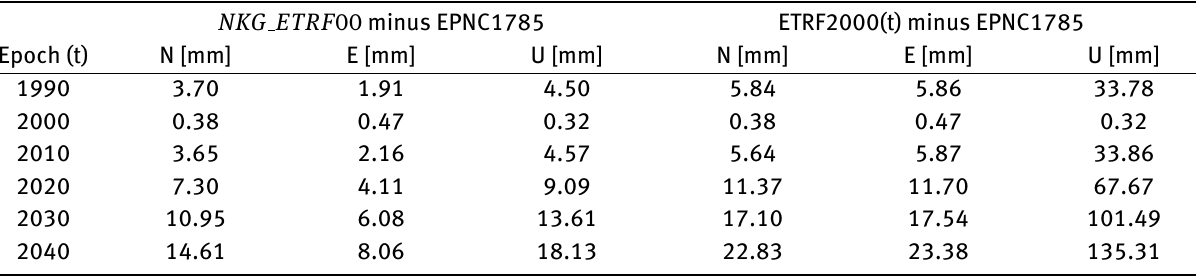
Table 6: RMS of coordinate differences: NKG ETRF 00 (aligned to the ETRF2000@2000.0) and ETRF2000(t) (no intraplate correction, eqs. 1-2) minus ETRF2000 coordinates of the EPNC1785 at the epoch 2000.0. The IGb08 coordinates of the EPNC1785 were first converted to the epochs 1990-2040 with IGb08 station velocities and then transformed to the NKG ETRF 00 or ETRF2000(t) and compared to the ETRF2000 coordinates of the EPNC1785 solution.